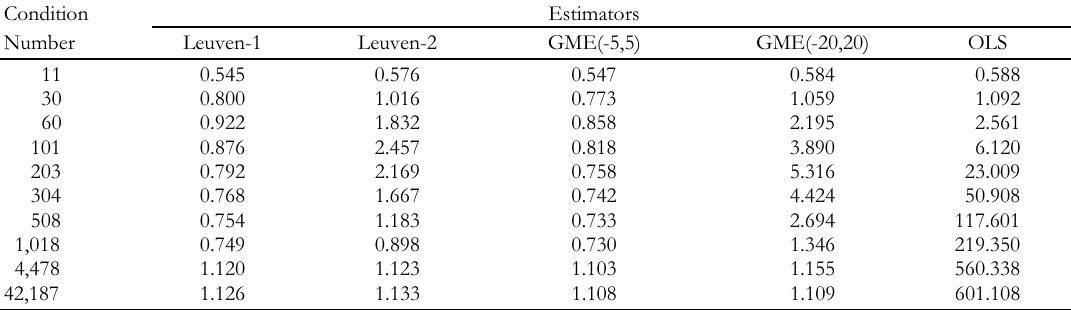
Monte Carlo experiment N. 1: model without intercept. MSEL of rival estimators for an increasing condition number. T=50, 100